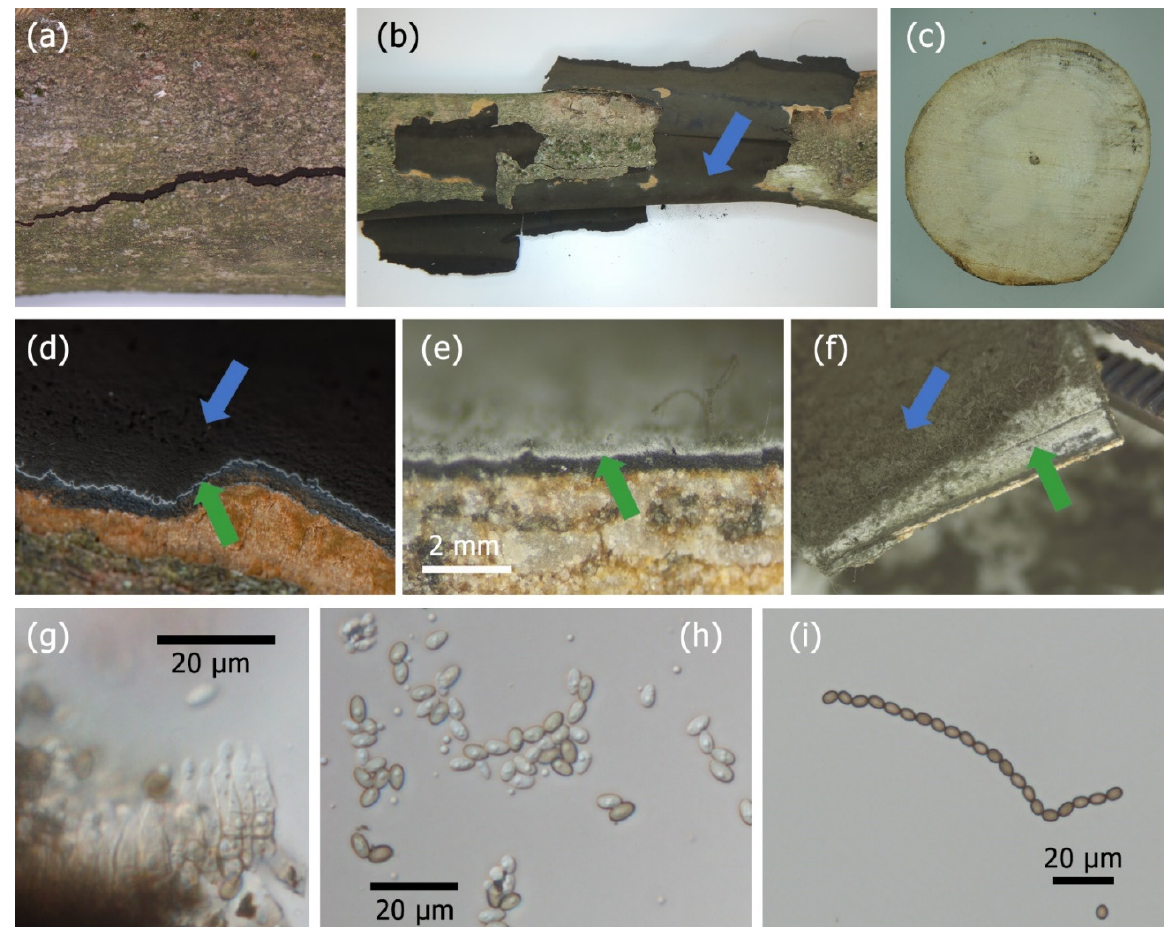
Figure 2. Symptoms and morphological characteristics of Cryptostroma corticale : ( a ) Crack in the bark; ( b ) bark easily peeled off where dark brown masses of spores were extruding; ( c ) sapwood and heartwood were discolored and quite degraded; ( d ) white edge of conidiomata; ( e ) stroma, white layer which produced conidia, and dark brown conidia; ( f ) perspective view of whitish layer of conidiophores with dense layer of dark conidia above it; ( g ) phialides that produced ovoid, hyaline conidia; ( h ) young, nearly hyaline ovoid-shaped conidia which became gradually darker; ( i ) ovoid-shaped, mature, dark brown conidia produced in a chain. Blue arrows show masses of conidia, green arrows show conidiomata. The ITS-rDNA sequence (Gen Bank Acc. No. MW575287) of a representative C. corti- cale isolate (ZLVG 859) showed 100% identity with reference sequences of C. corticale (e.g., MH857008 from isolate CBS